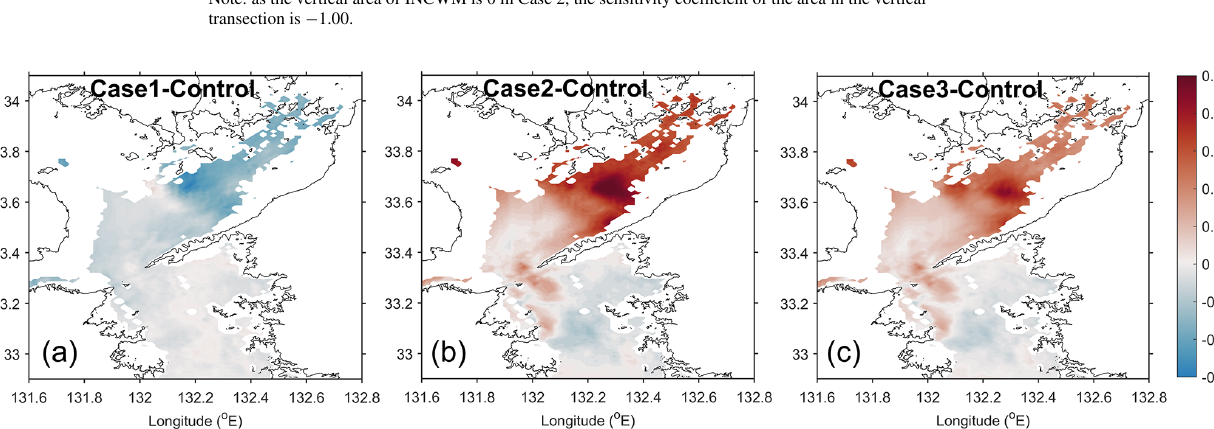
Figure 8. The spatial distribution of temperature difference ( ◦ C) between sensitivity numerical experiments and Control run at 50m depth in